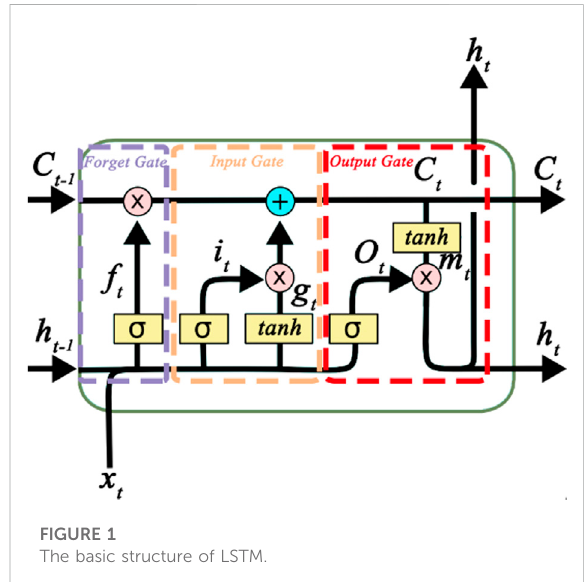
FIGURE 1 The basic structure of